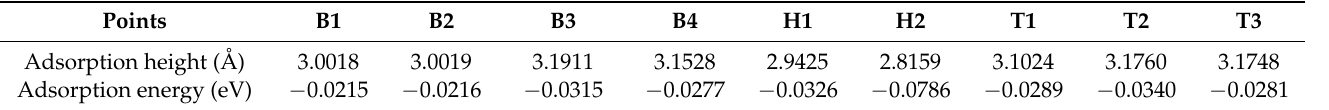
Table 2. Hydrogen adsorption height and adsorption energy of nine